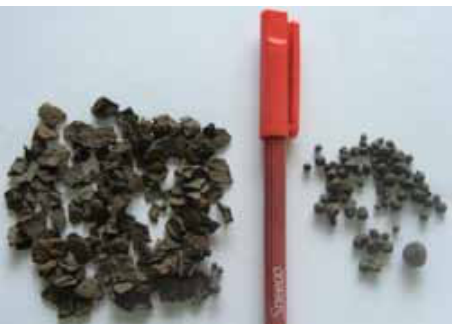
Fig 11: The scale (left) and droplet (right) slags of Nundu